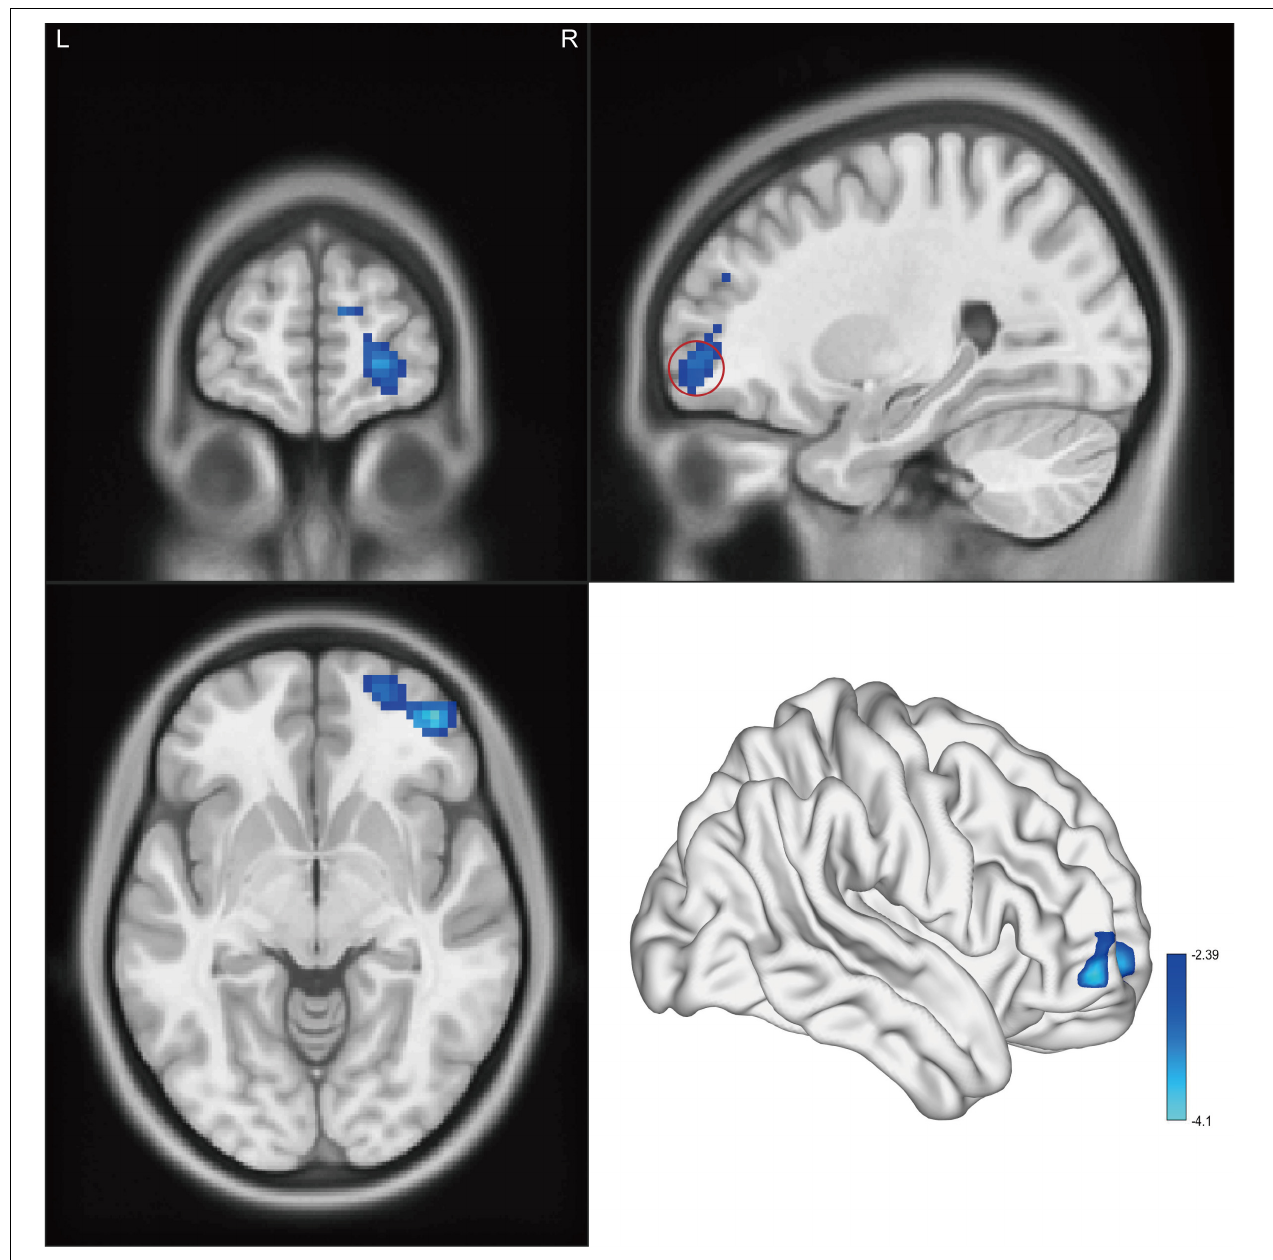
FIGURE 2 | Cluster showed a significant difference in fALFF between CAI patients and HCs. The color bar indicated the t -value from two-sample t -test. The red circle indicated the orbital-frontal